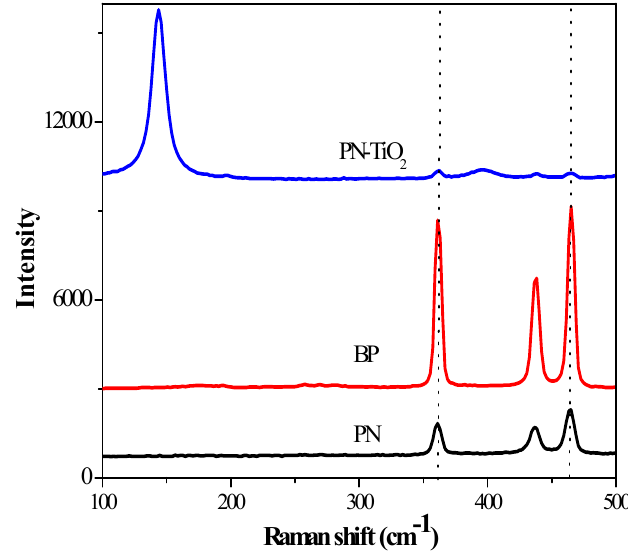
Figure 3. Raman spectra of BP, PN, and PN-TiO 2 .